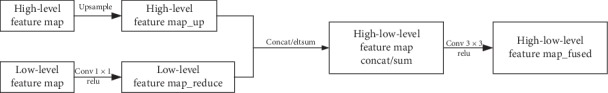
Fusion module b.